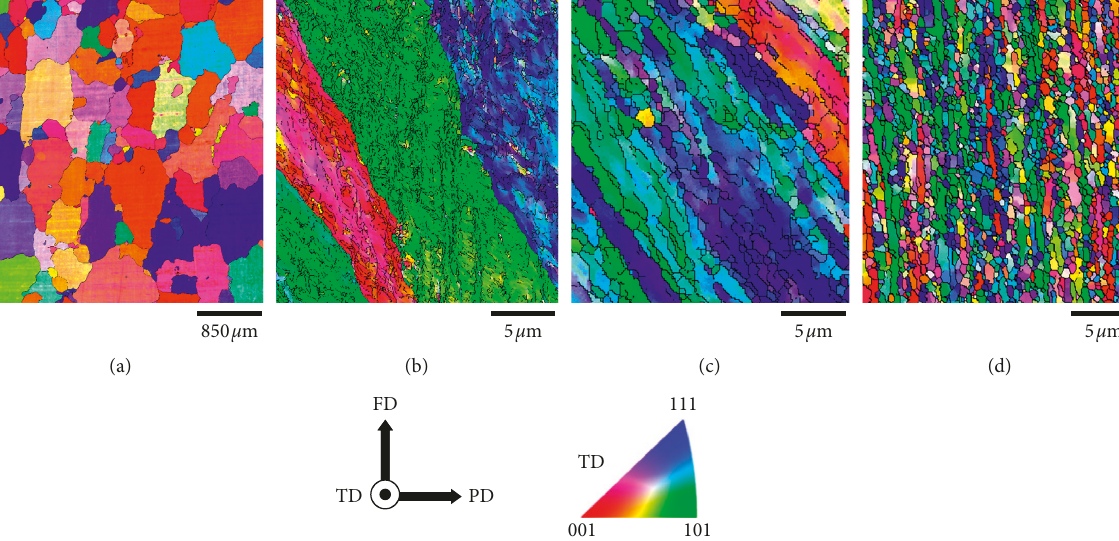
Figure 4: EBSD microstructures of (a) initial sample and (b) left edge area (LEA), (c) middle area (MA), and (d) right edge area (REA), respectively, of the fin for the case of t 0 . (cid:31)